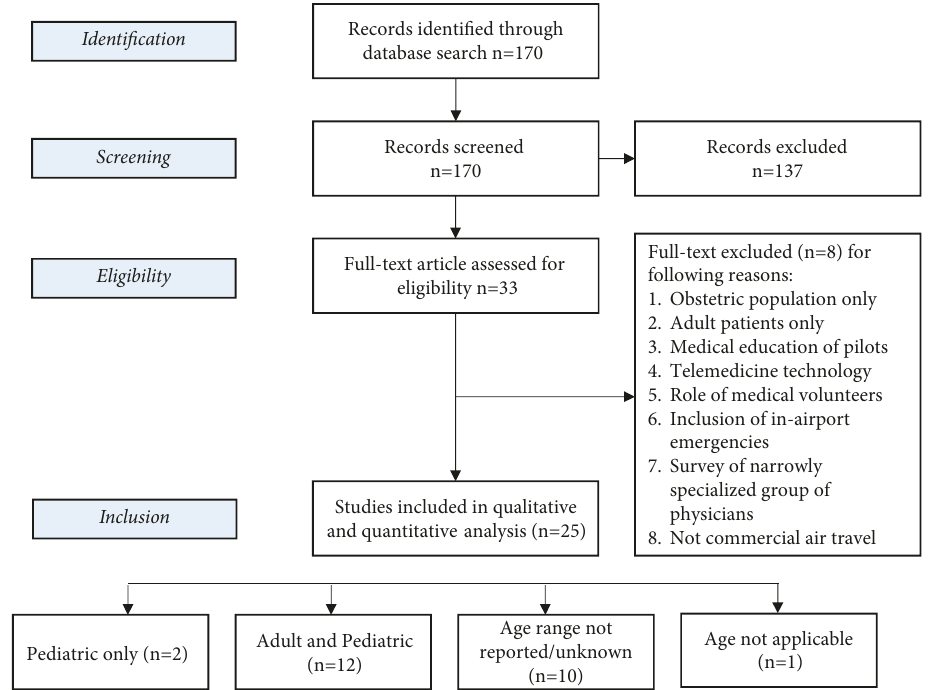
Figure 1: Flow of studies through the review according to the PRISMA